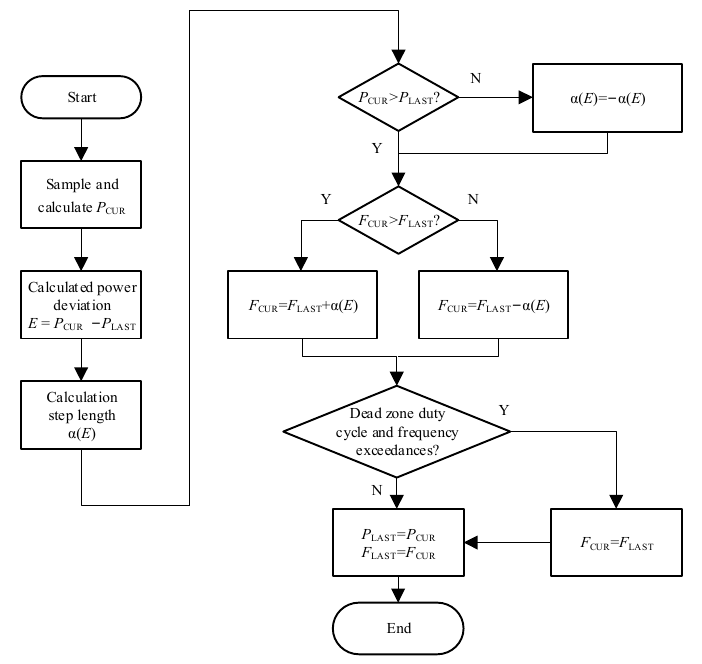
Figure 6. Flow chart of maximum power tracking program based on PFM.